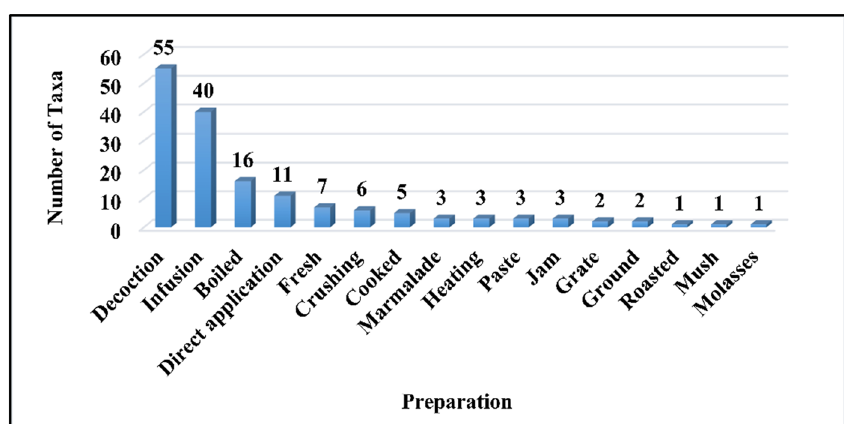
Figure 4: Preparation methods of folk medicines in the region.